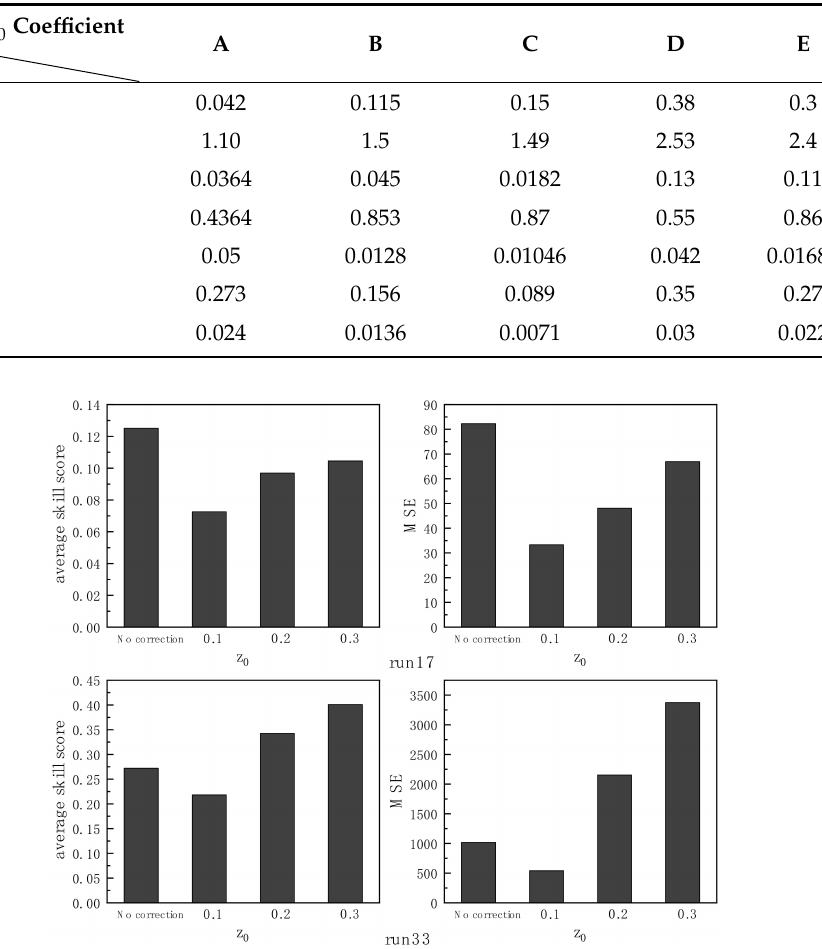
Figure 8. Performance of the modified Gaussian diffusion model in source term